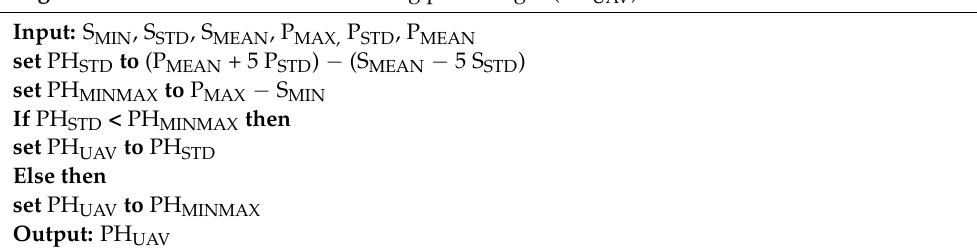
Algorithm 1 : Pseudo-code for estimating plant height (PH UAV